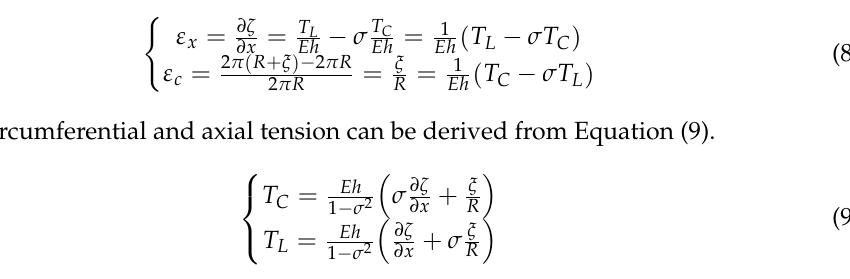
elastic tension and assuming that the Young’s modulus of the blood vessel wall is E , the Poisson ratio of the blood vessel is σ , and the thickness of the blood vessel is h , the axial strain and circumferential strain of the blood vessel wall are shown in Formula (8).